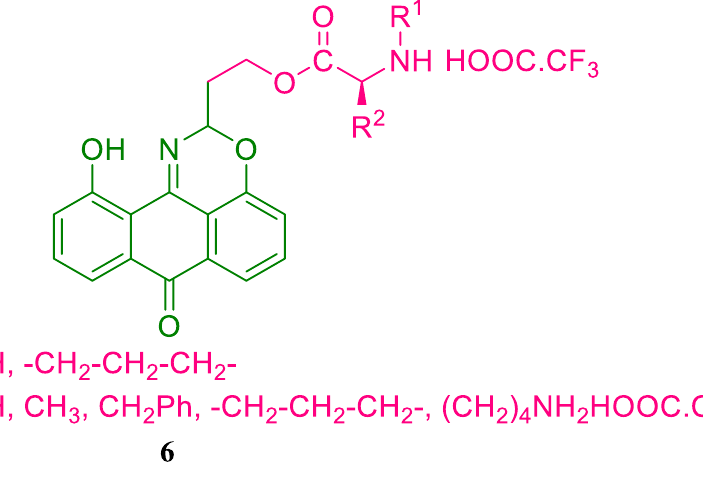
Figure 16. Amino acids-oxoazabenzo[ de ]anthracenes hybrid molecules.